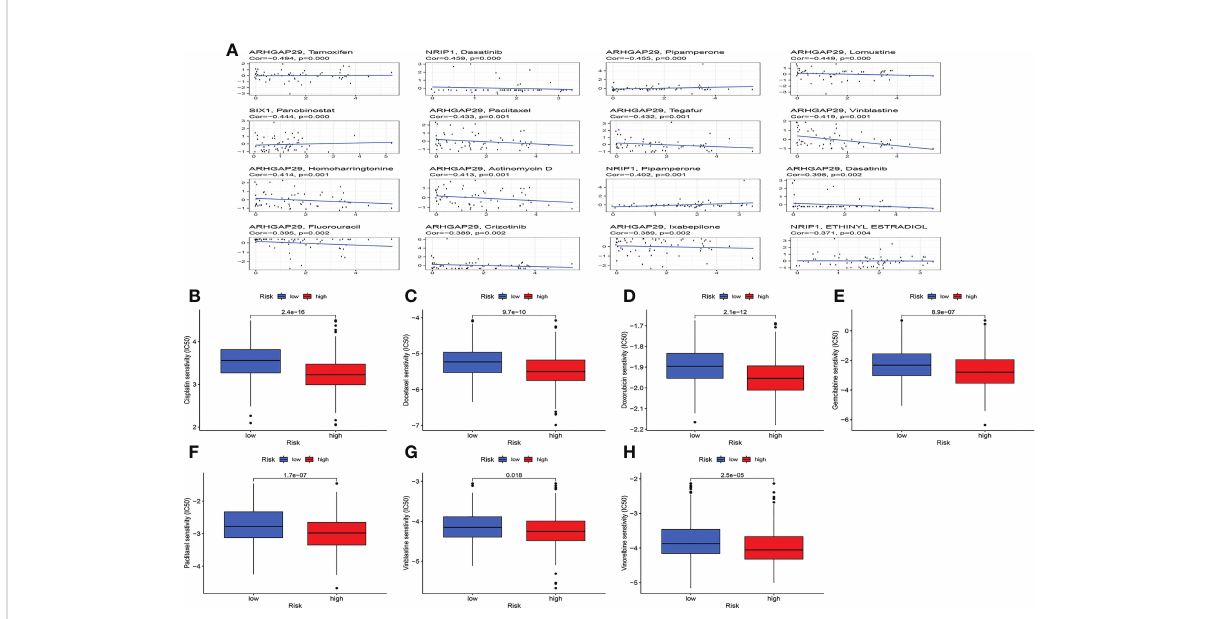
FIGURE 8 Drug sensitivity analysis. (A) Relationship between model genes and sensitive drugs. (B-H) Sensitive drugs in high-risk